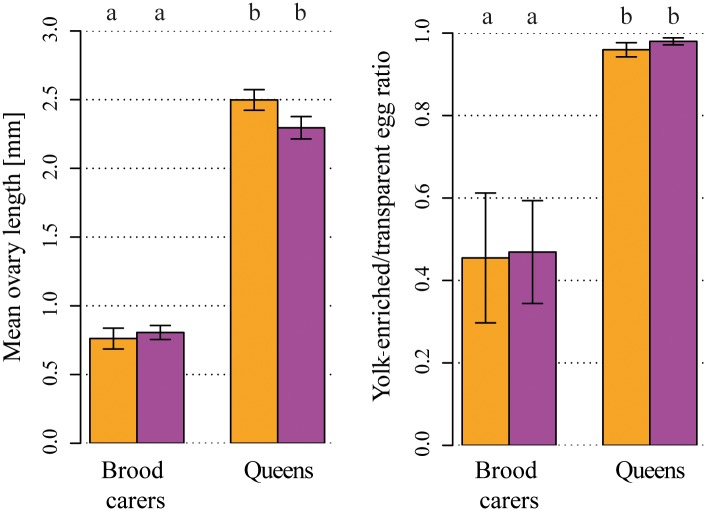
Fertility of brood carers and queens was not influenced by Vg-like A knockdown.Mean ovary length (left) and yolk-enriched/transparent egg ratio (right) exhibited strong caste differences but were independent of Vg-like A knockdown (Orange: control; purple: Vg-like A knockdown). Vg, vitellogenin.